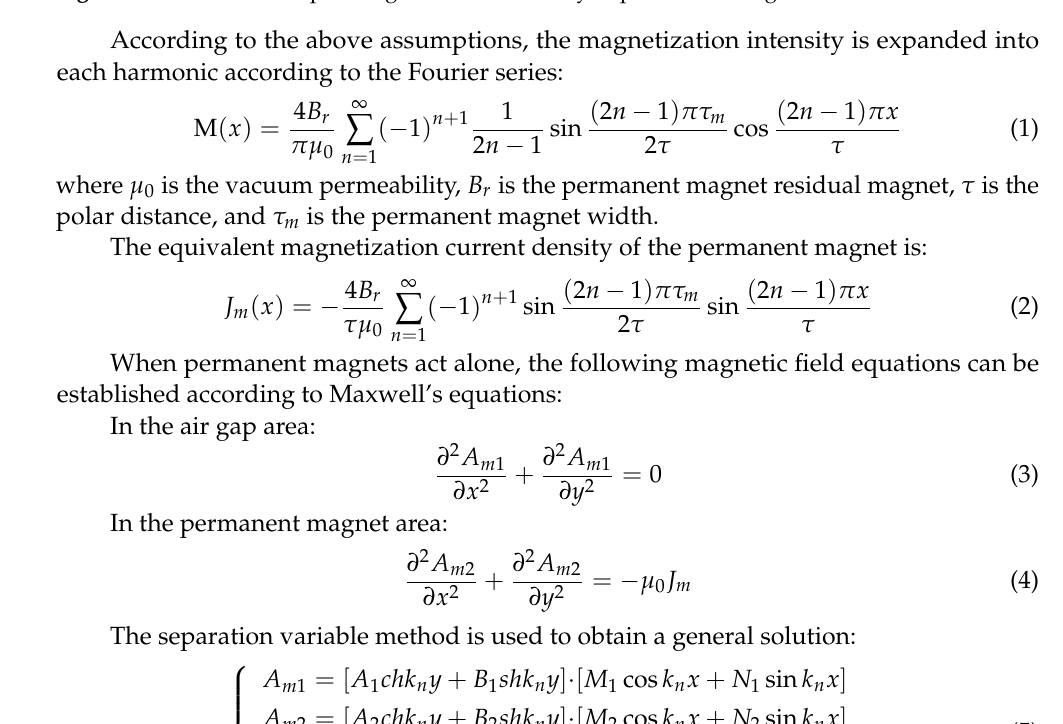
Figure 4. Distribution map of magnetization intensity of permanent magnets.